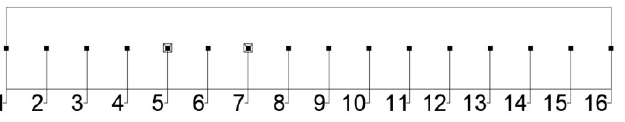
Figure 6. Layout plan of measuring points.